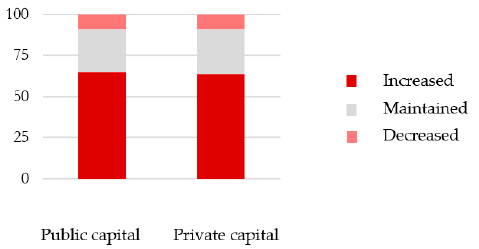
Figure 1. Percentage of respondents’ answers regarding the evolution of the number of water disconnection notifications between 2011 and 2014.